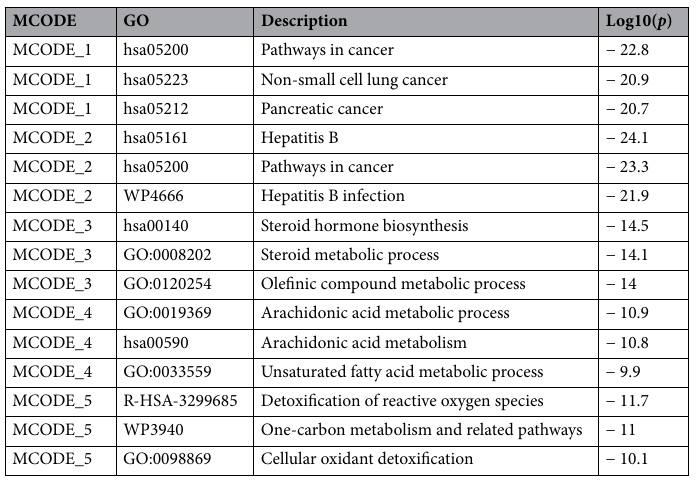
Table 2. MCODE enrichment analysis of the potential targets involved in naringenin treatment of chronic